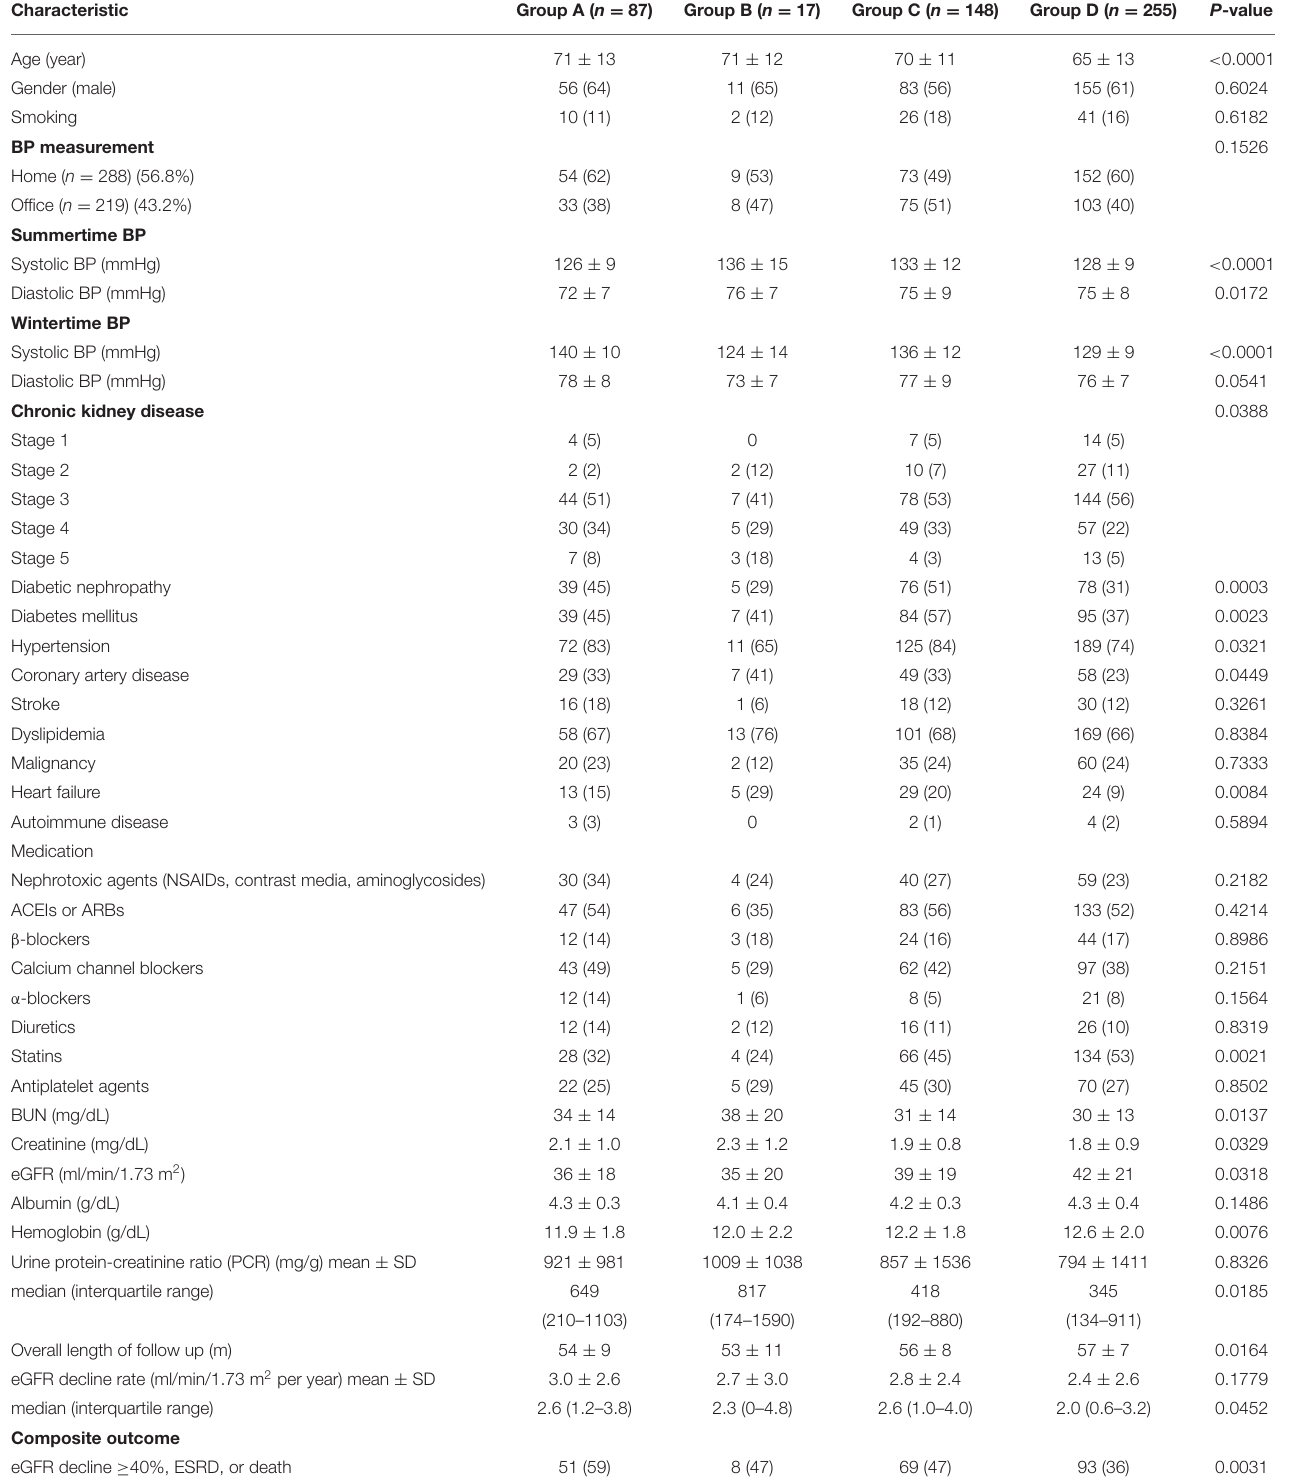
TABLE 1 | Baseline characteristics of 507 CKD patients in relation to the pattern of seasonal BP change.